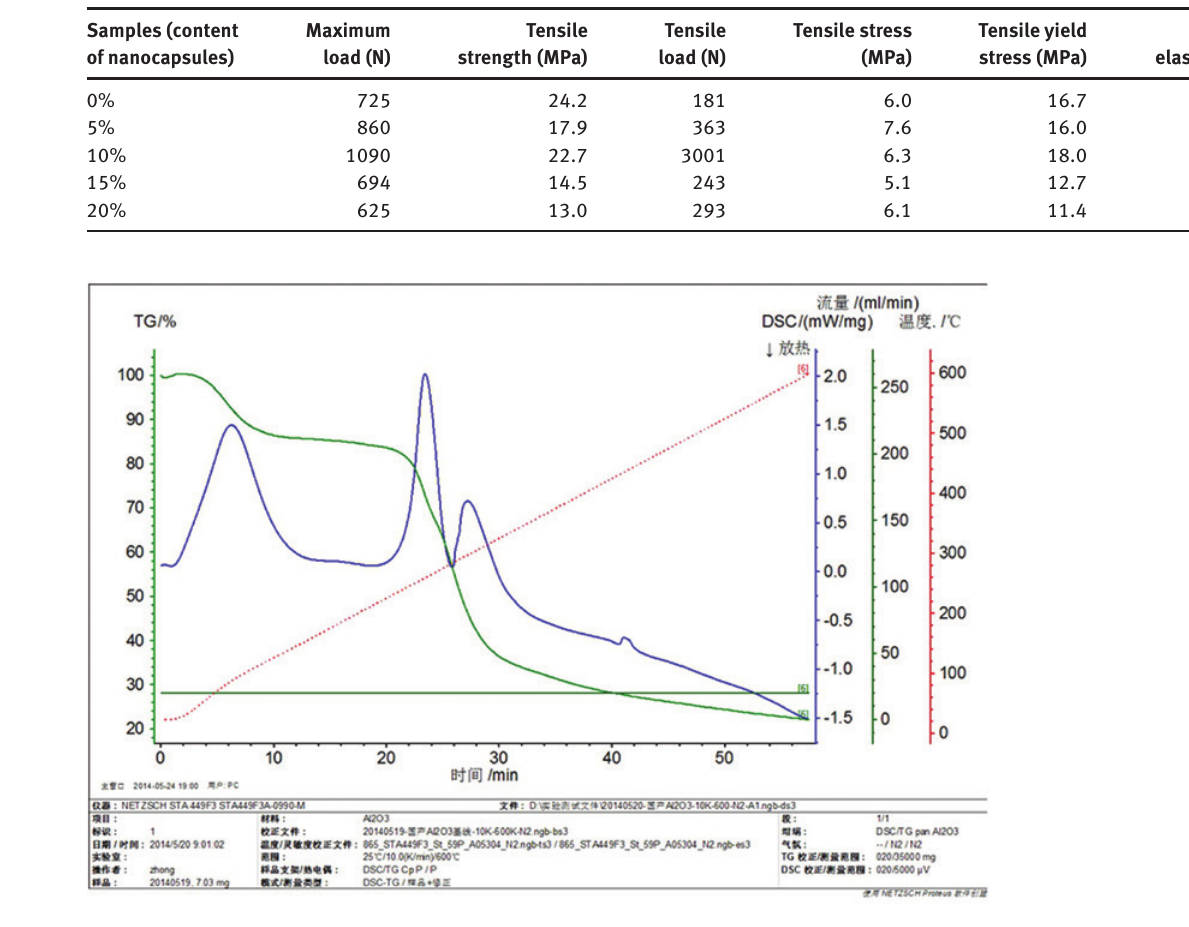
Figure 2: TG and DSC curves of nanocapsules.